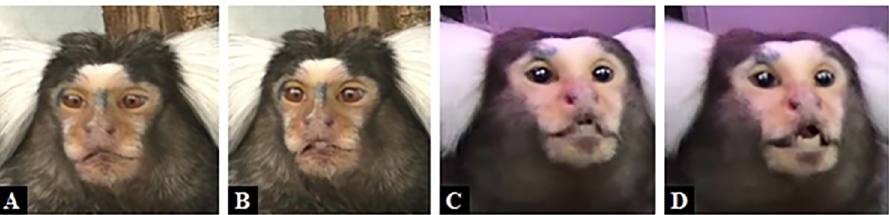
Fig 14. AU16—Lower Lip Depressor. A : Neutral; B : AU16 pulls the lower lip downwards medially; C : AU16 pulls the lower lip downwards medially and laterally; D : AU16 pulls the lower lip further down (AU12 also present).